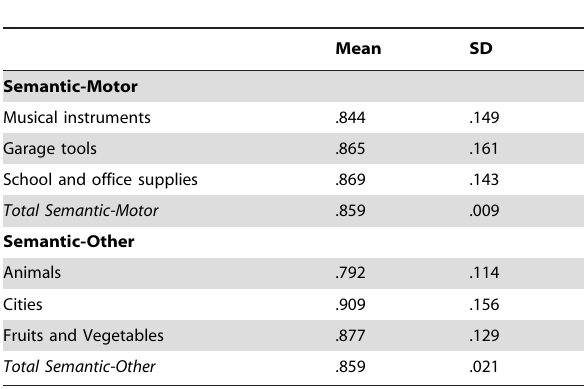
Table 2. Word Duration Means by Semantic Condition (Exp